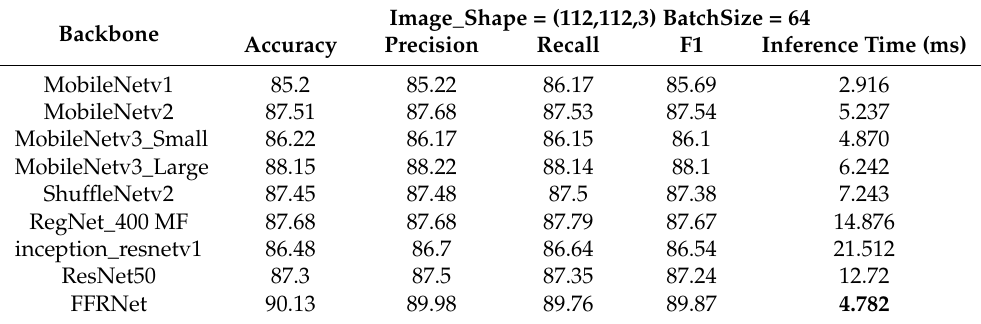
Table 8. Comparative experiment of different models and FFRNet. In addition to the real-time inference speed, FFRNet achieved the best results. The picture size of the experimental table is 64 × 64. Backbone